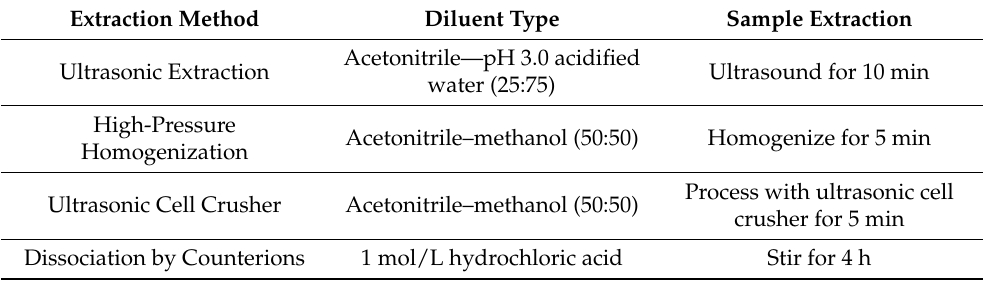
Table 1. Study of extraction